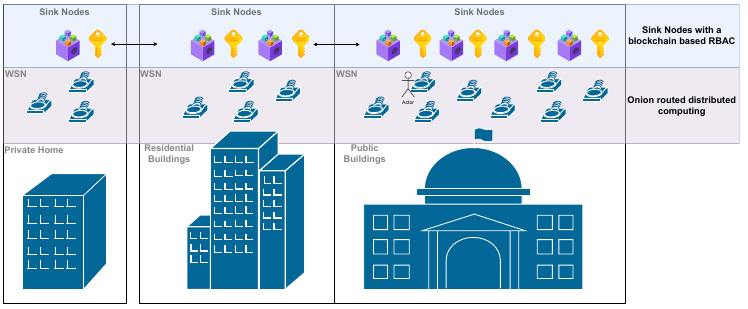
Figure 1. A layered system